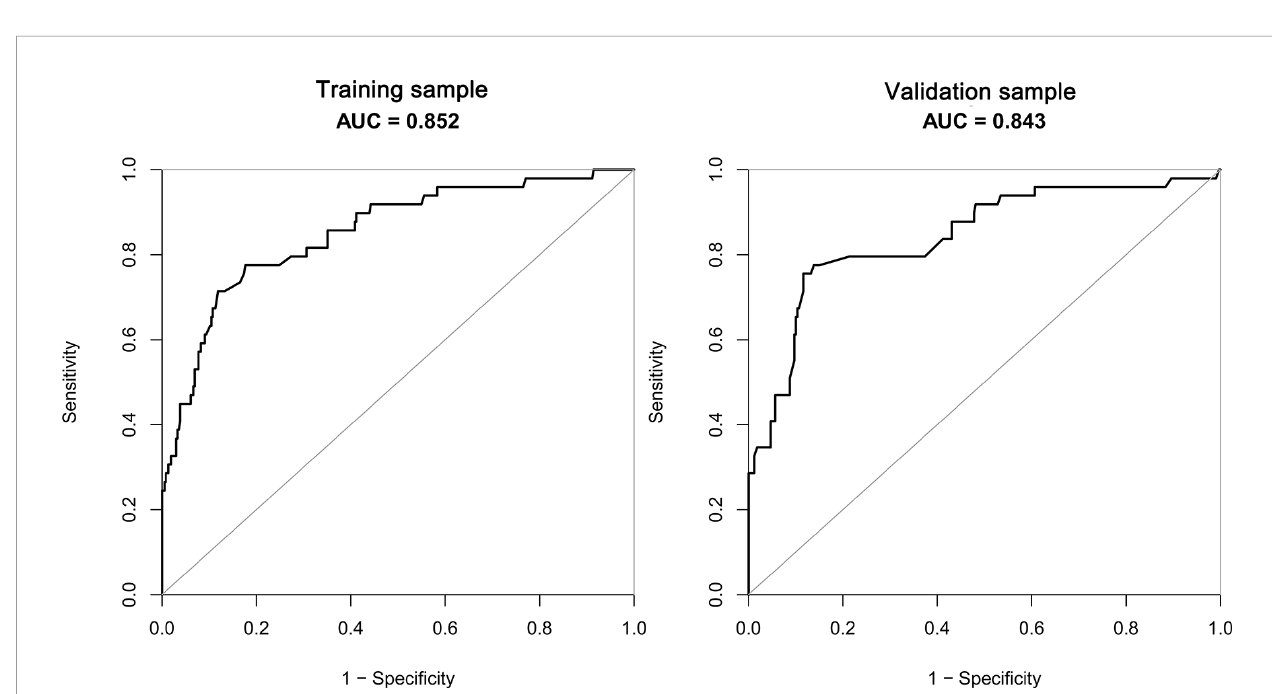
FIGURE 3 | The AUC of training sample (AUC=0.852) and validation sample (AUC=0.843) showed that the model had a high discrimination